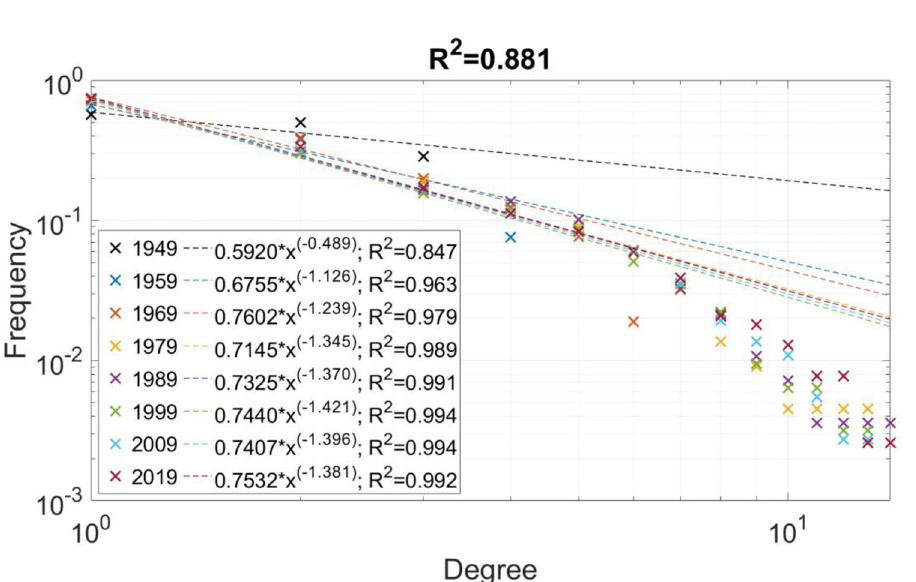
Figure 5. Cumulative node degree distribution and power-law